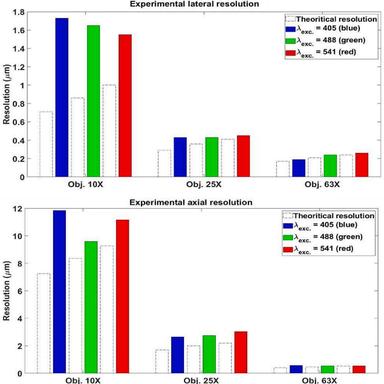
Bar graph comparing the experimental resolution and theoretical resolution of the SL8 confocal imaging system summarized in Table S.1. The 25X objective denoted in this graph is the oil-immersion objective.